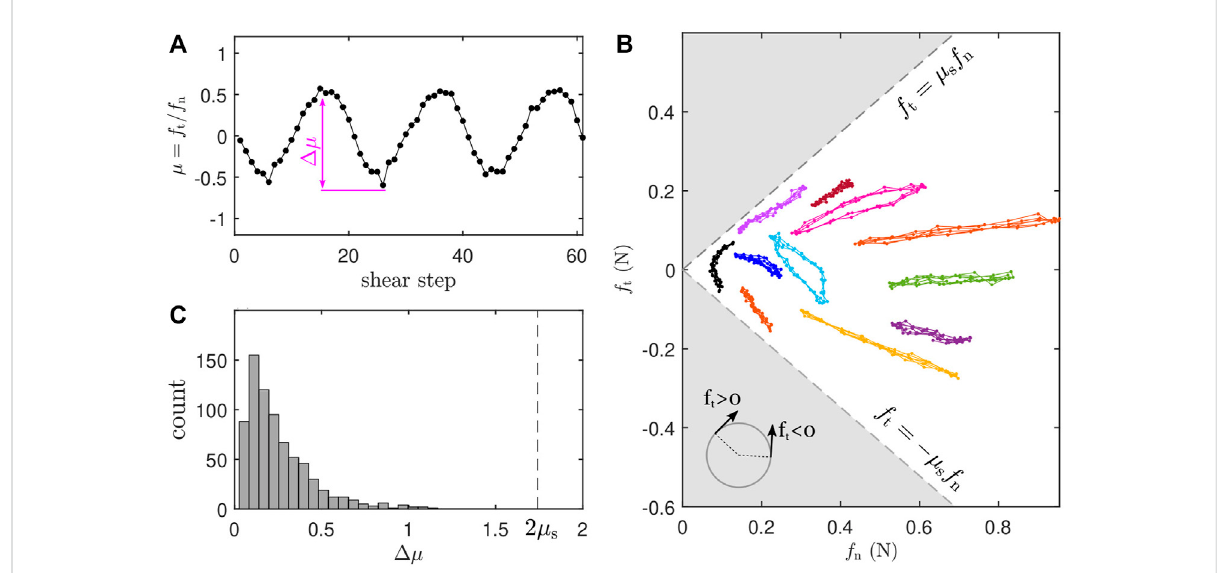
FIGURE 4 Noevidenceofsliding atpersistentcontacts.All datainthis fi gure arefromthesameultrastablestate asinFigure 3. (A) Theevolutionof μ = f t / f n for an example persistent contact over three consecutive shear cycles. (B) The evolution of forces on several example persistent contacts. Different colors represent differentcontacts. See Supplementary Video S2for one example. The two dashed lines mark theconditions for the onset of sliding, where μ s =0.87 is thestaticfriction coef fi cient. The grey regions are inaccessible. The black data correspondsto the example contact shown in (A) . The inserted schematic plots the sign convention for the tangential force components. (C) The number distribution of Δ μ for all persistent contacts. The dashed line marks the value expected for a sliding